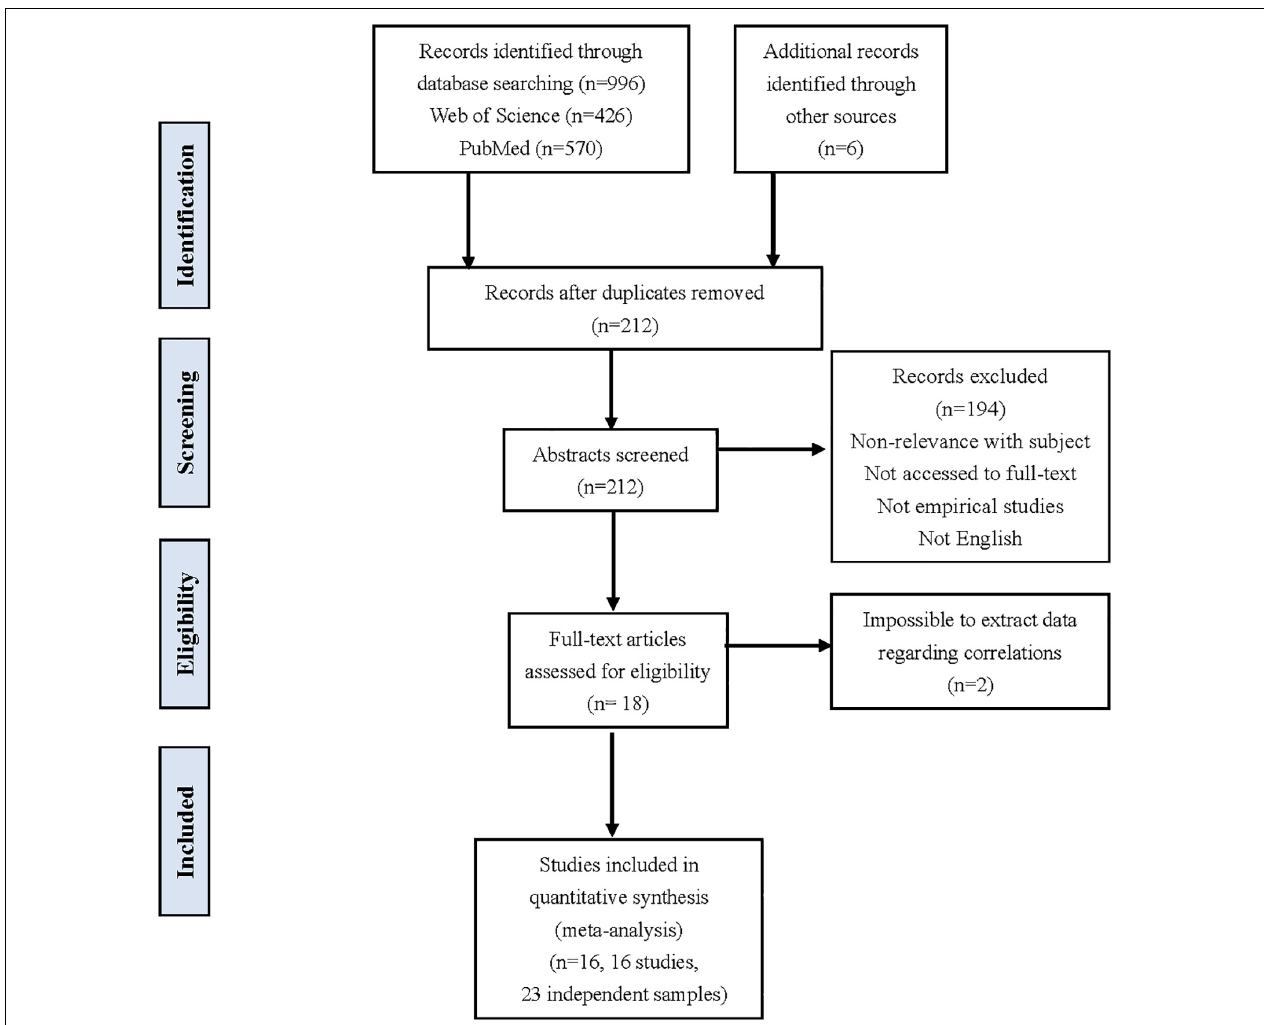
FIGURE 1 | The literature search and selection procedure of the current